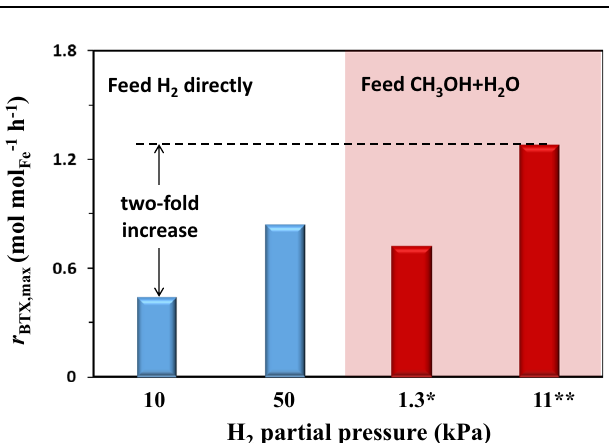
Fig. 4 Effects of H 2 partial pressure and feed source on BTX formation rates. Reaction condition: 450 °C, 0.5 kPa guaiacol, balanced by N 2 , was either directly produced via feeding gaseous H 2 or generated in situ via methanol stream reforming by cofeeding CH 3 OH and H 2 O instead of H 2